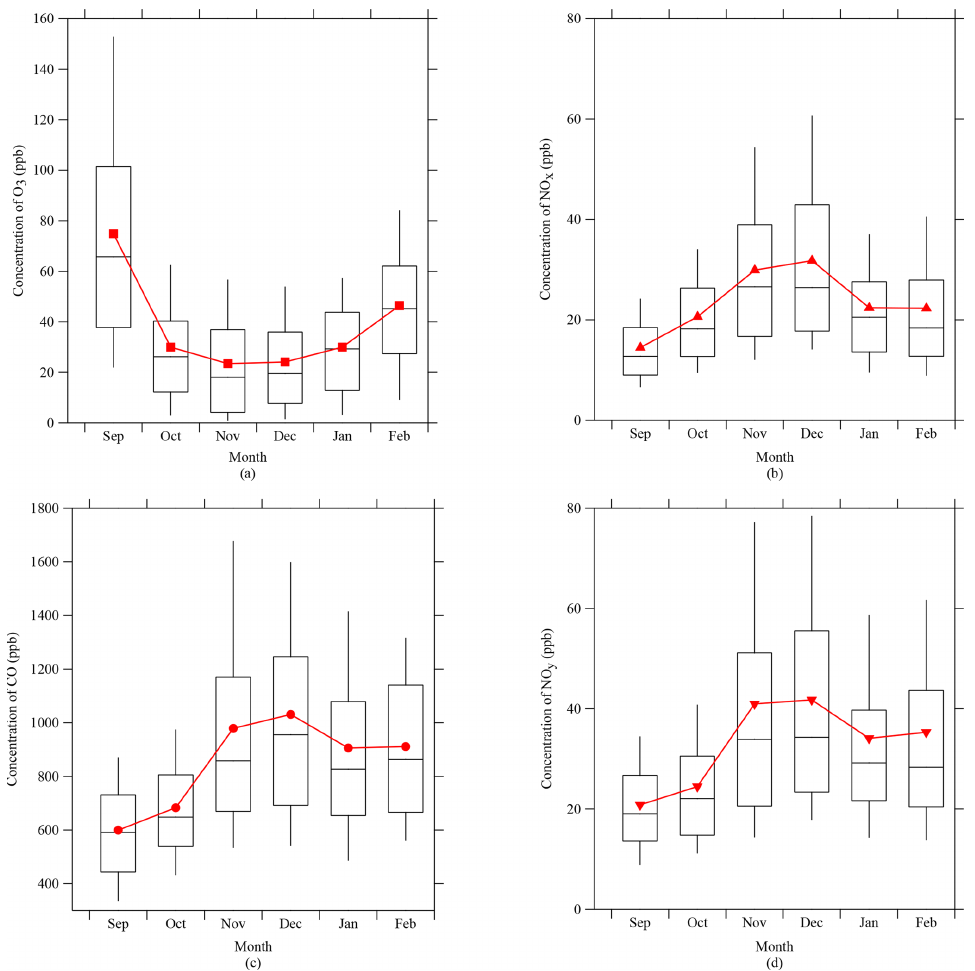
Figure 5. Seasonal variations of (a) O 3 , (b) NO x , (c) CO, and (d) NO y . The 10th, 25th, 50th, 75th, and 90th percentile values of each are shown in black, and red markers represent the monthly averages. Table 4. Statistics of trace gases during the study